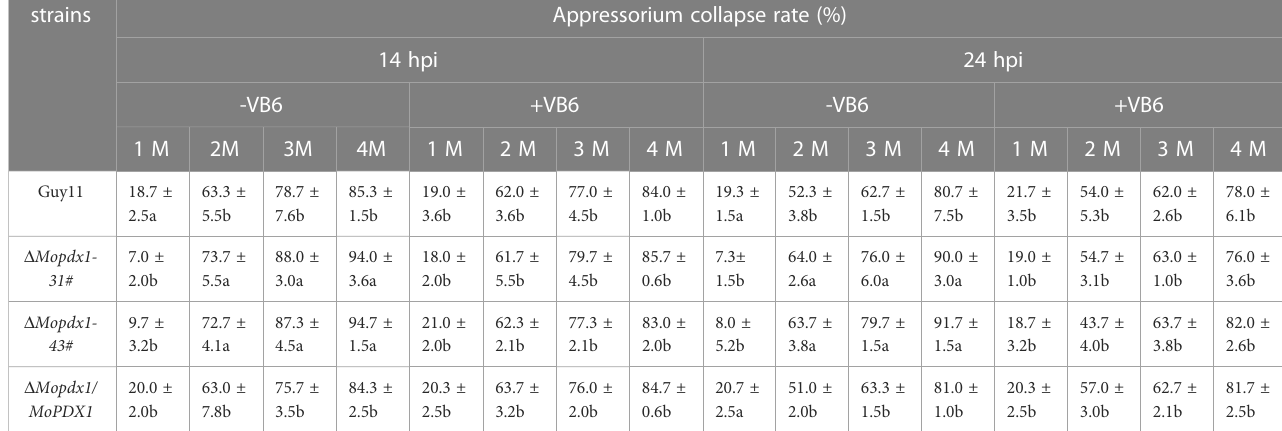
TABLE 5 Appressorium turgor pressure assays of the wild type, D Mopdx1 mutant, and the complement strains with or without 10 -4 mg/mL of VB6 at 14 or 24 hpi, respectively.